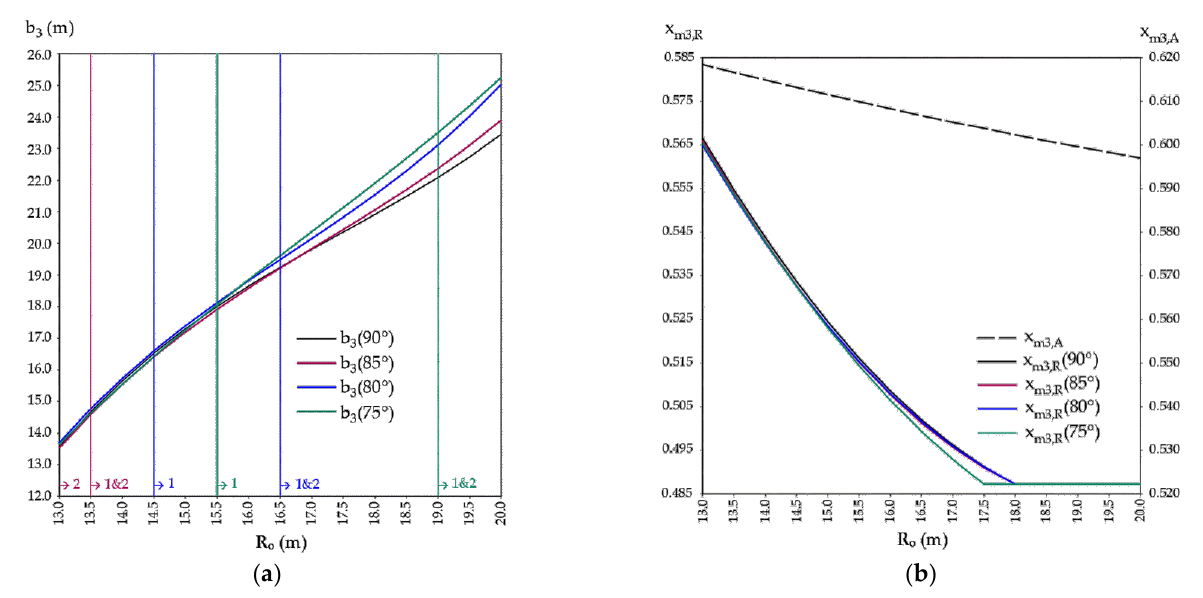
Figure 11. Investigated parameters at leg 3 as a function of R o for different δ, considering the application of design conditions 1 and 2: ( a ) geometric parameter b 3 ; ( b ) traffic parameter x m3 .